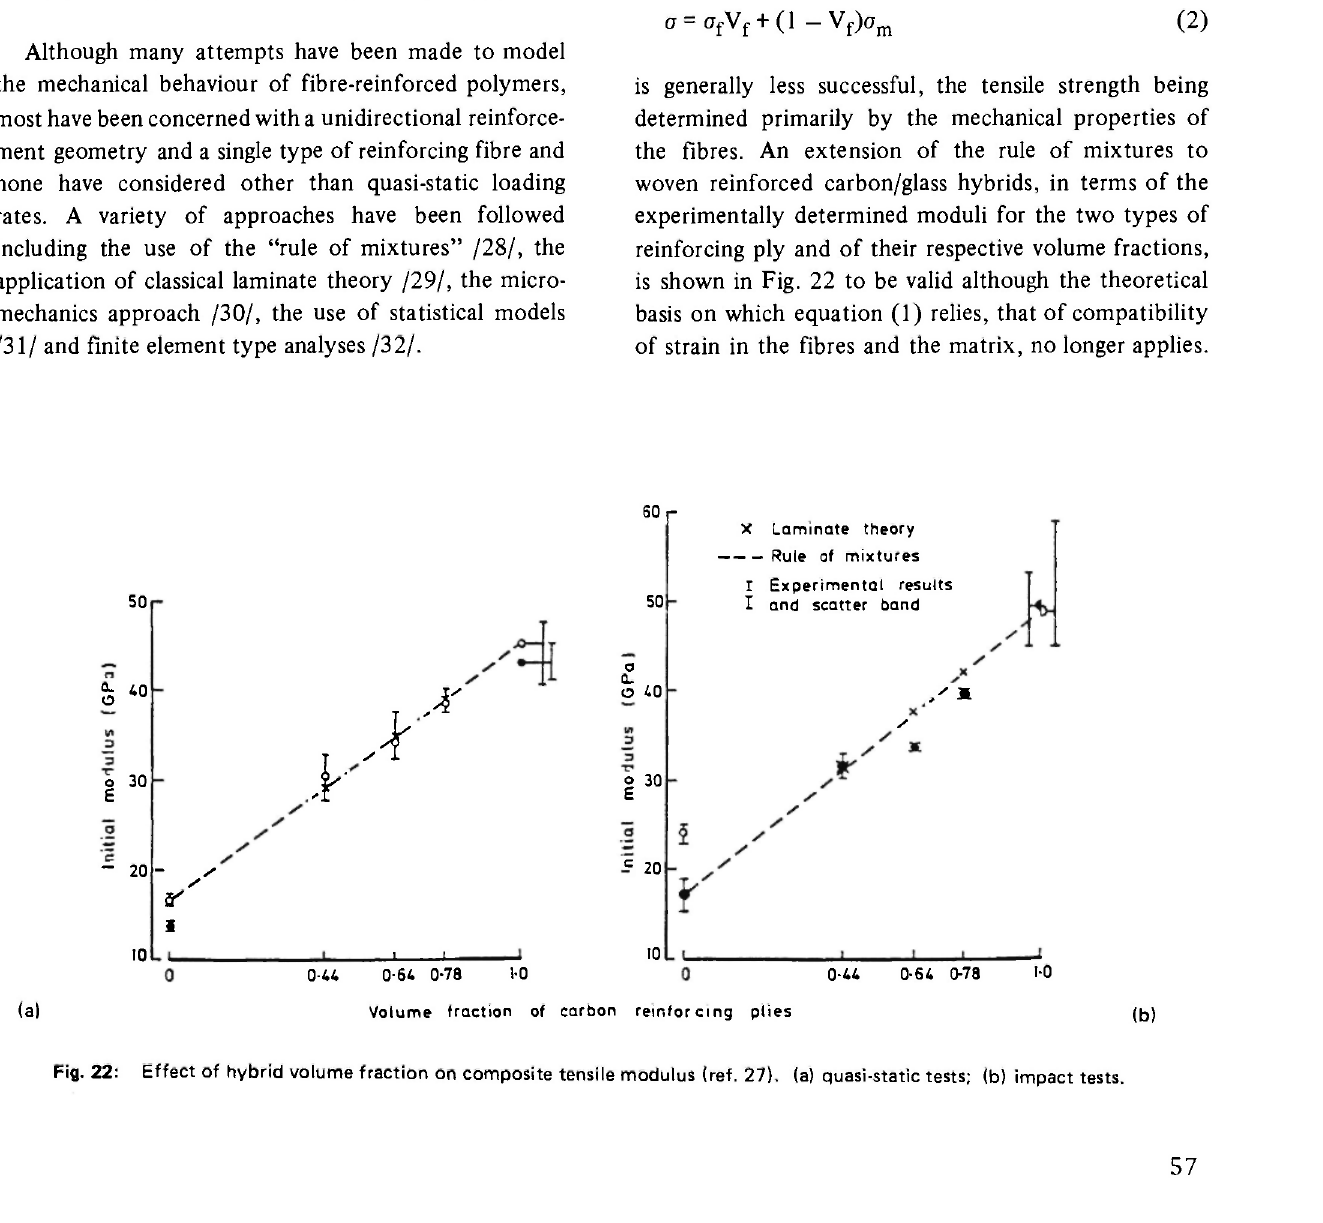
Fig. 22: Effect of hybrid volume fraction on composite tensile modulus (ref. 27). (a) quasi-static tests; (b) impact